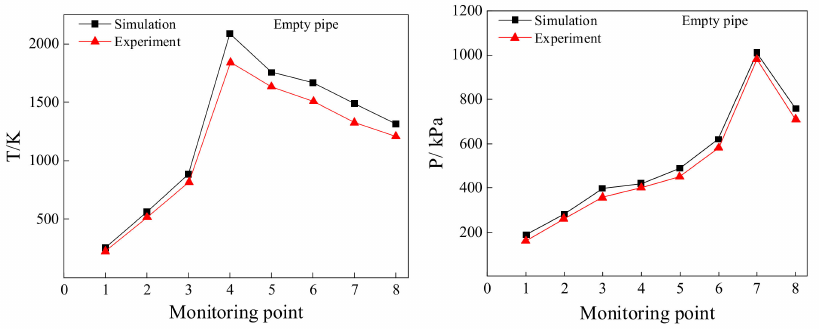
Figure 3. Maximum temperature and overpressure at each monitoring point for empty pipe.